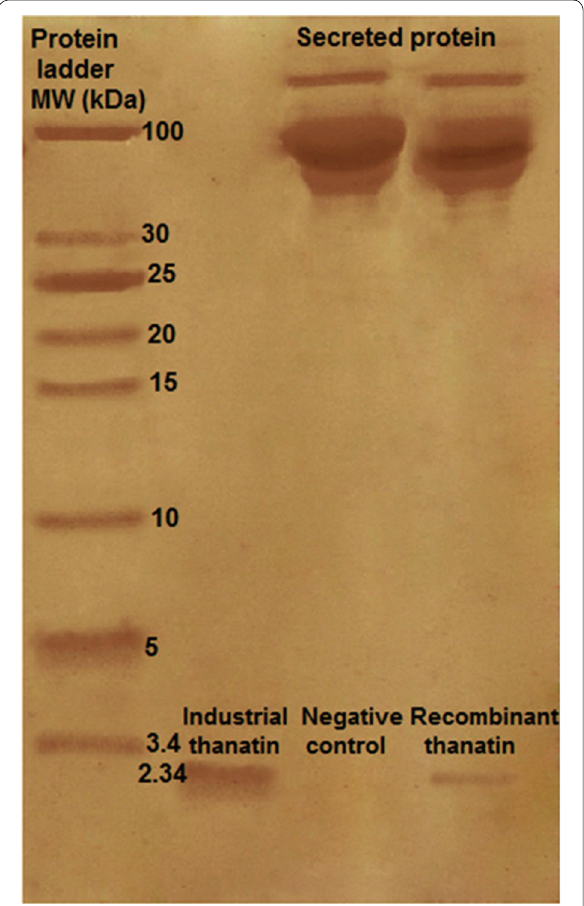
Fig. 1 SDS-PAGE analysis of HEK293 secreted protein in medium alongside with a low molecular protein ladder, industrial thanatin and negative control. The peptide band with the size of 2.34 kDa represented